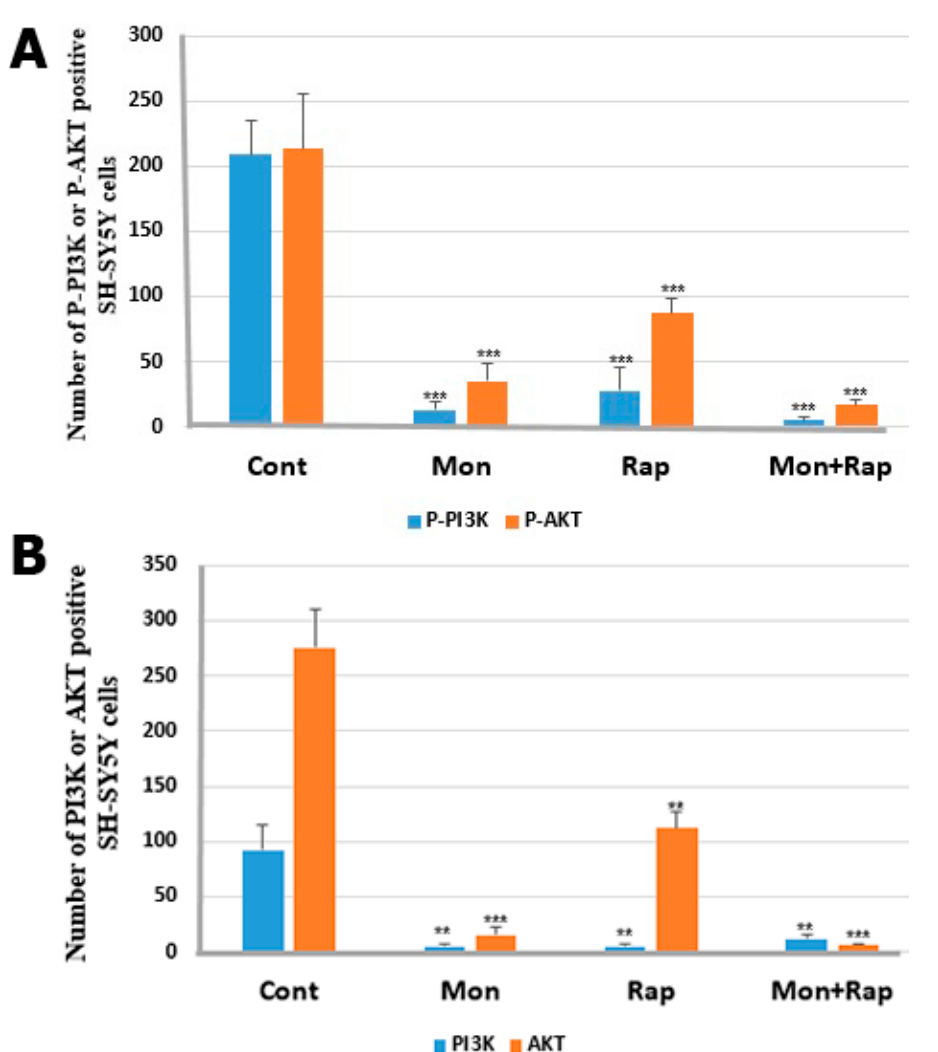
Figure 4. Statistical analysis of the effects of single and combined doses of mon and rap on the PI3K/AKT pathway. ( A , B ) Significant differences were found between control and treatment groups. Data are presented as mean ± SD. n =3. ** p < 0.01, *** p < 0.001.